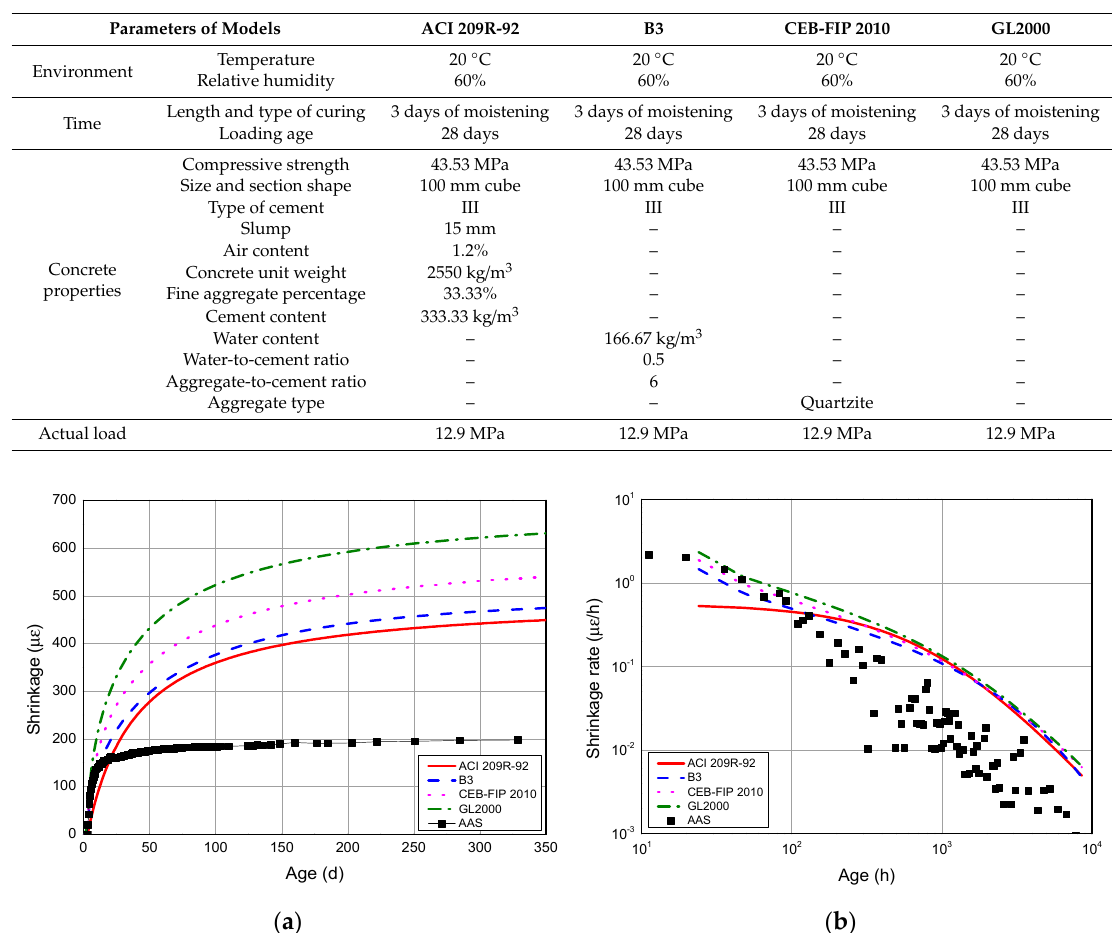
Table 4. Parameters input for predicting the shrinkage and creep (“–” indicates that the model does not take this parameter into account).